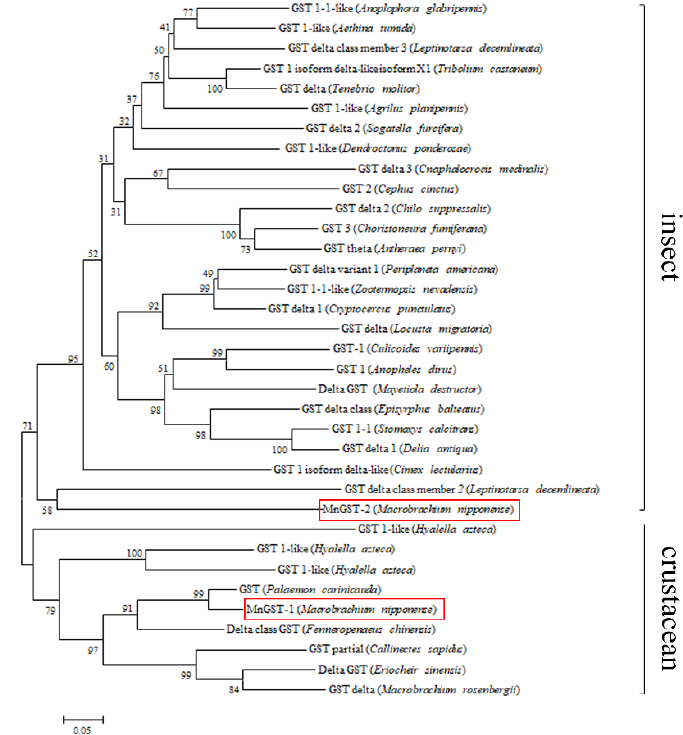
Figure 1. Phylogenetic tree based on GST sequences generated using the neighbor-joining method in the MEGA 5.10 program with 1000 bootstrap replicates. MnGST-1 and MnGST-2 were highlighted in red boxes. Table 2. Mature peptide sequences of glutathione S-transferase (GST) family members. Species